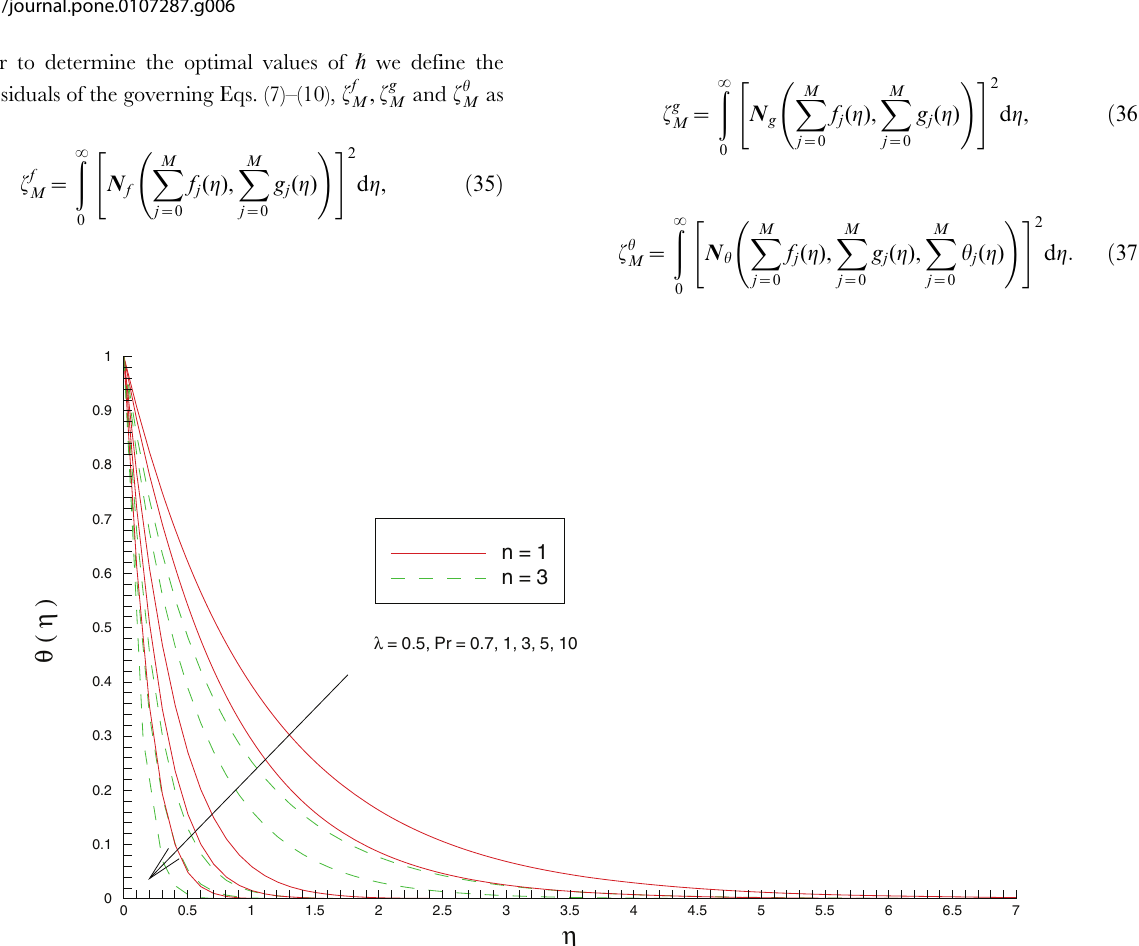
Figure 6. Influence of stretching rates ratio l on the temperature h :